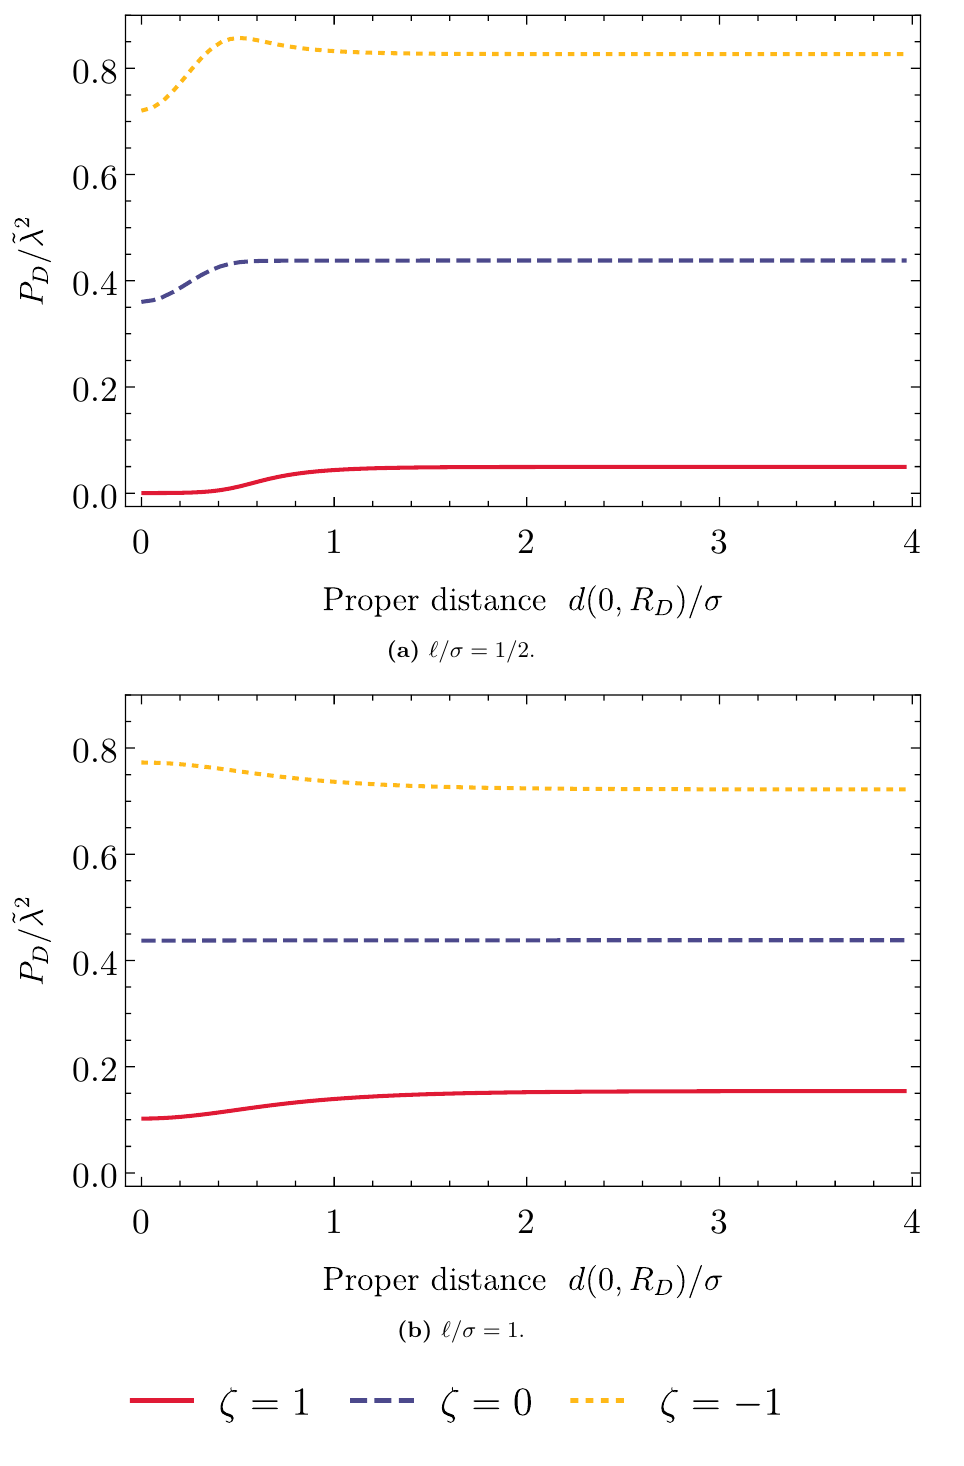
Figure 3 . The transition probability P D of a static detector with energy gap (cid:10) (cid:27) = 1 = 100 is plotted as function of its proper distance from the origin for an AdS length of (a) ‘=(cid:27) = 1 = 2 and (b) ‘=(cid:27) = 1 for all boundary conditions (cid:16) = f 1 ; 0 ; (cid:0) 1 g .